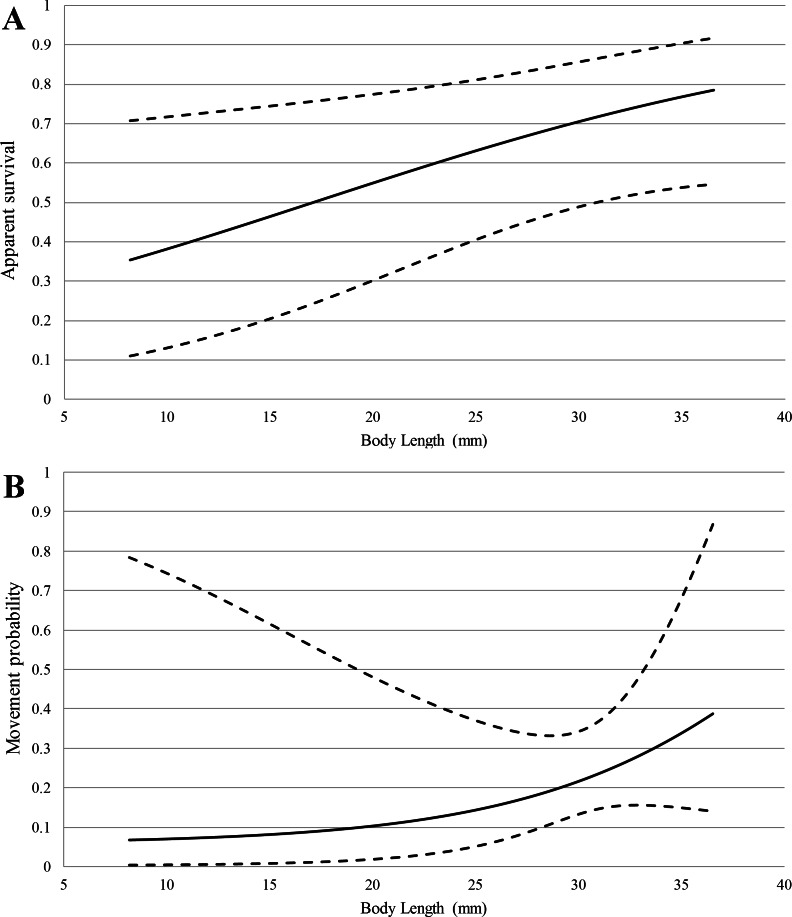
Model-averaged estimates (solid lines) of apparent survival (A) and movement probability (B) vs. body length with 95% confidence intervals (dashed lines) from multi-state capture-recapture analysis.